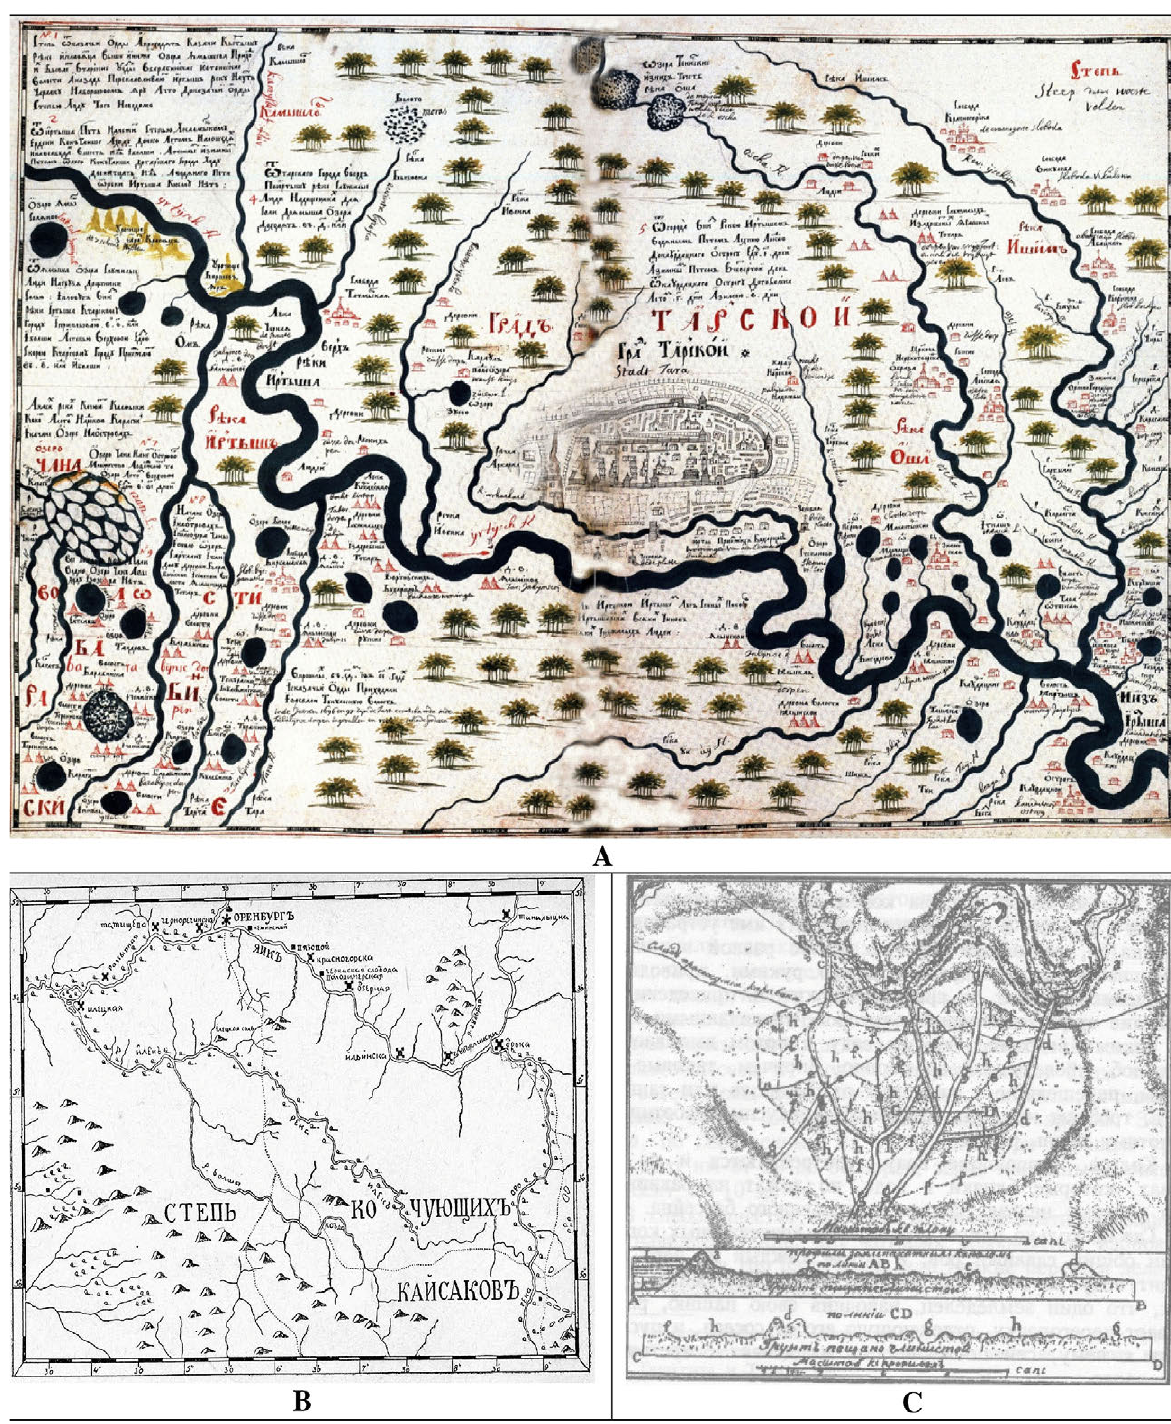
Fig. 3. A – The Siberia Sketch cartographic map with geographical loci along the Irtysh River presented by S.U. Remezov (dated to 1697); B – The Kaysakov (Kazakh) nomadic steppe south of the Irtysh/Yertys River; C – A Kyrgyz (Kazakh) steppe-setting plan of arable